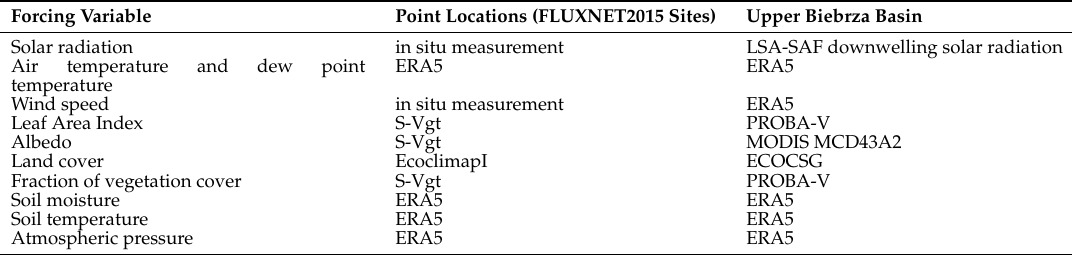
Table 2. Overview of data sources to force the ET model at flux tower locations and across the study area in the upper Biebrza basin, Poland. The SPOT-Végétation (S-Vgt) and PROBA-V products were generated in the framework of the Copernicus Global Land Service at a 1 km and a 300 spatial resolution, respectively. LSA-SAF, Land Surface Analysis programme (LSA-SAF); ECOCSG, Ecoclimap